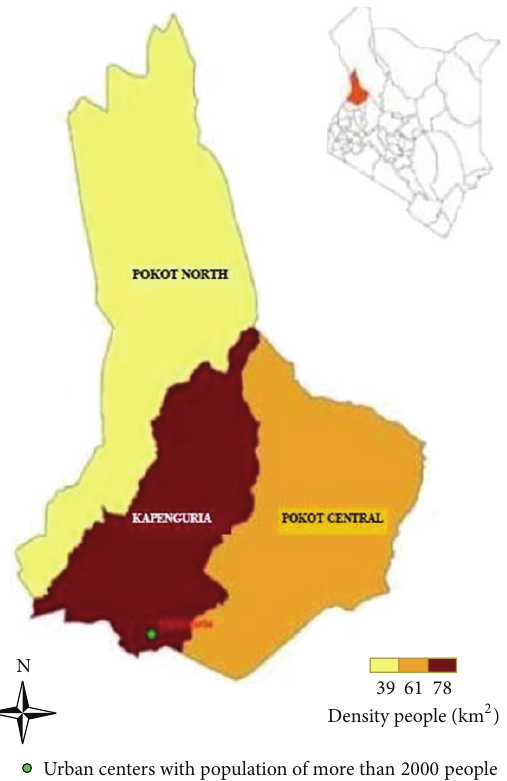
Figure 1: A map of West Pokot